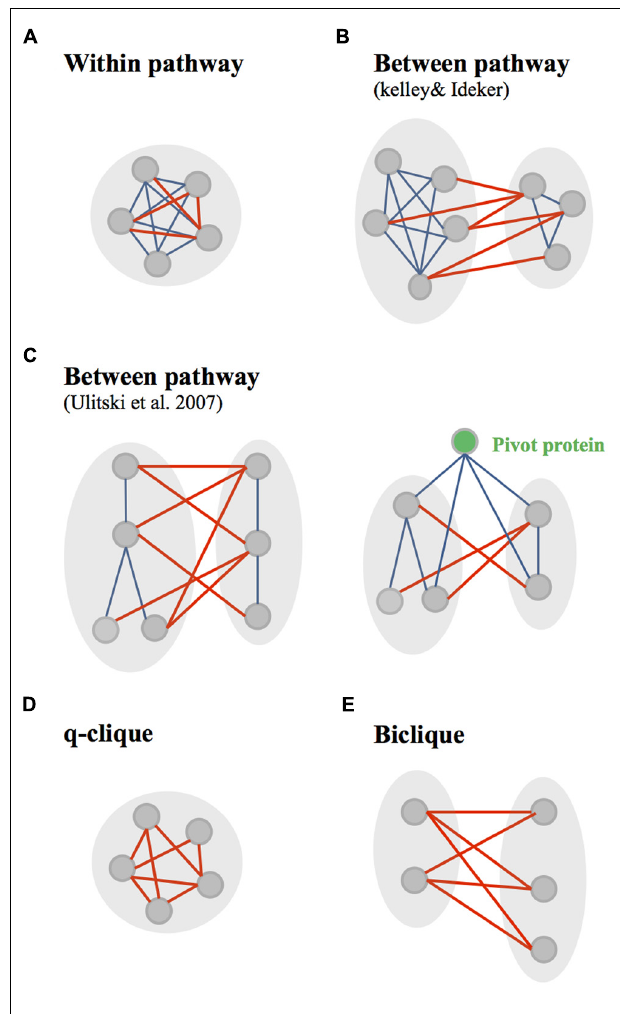
FIGURE 3 | Canonical and non-canonical within/between pathway models. (A) The canonical within pathway model as described by Kelley and Ideker, consists in genetic interactions (GIs, red edges) occurring within a dense module of protein interactions (bleu edges). (B) The canonical between pathway models, as described by Kelley and Ideker (2005) , consists in GIs occurring between dense modules of protein interactions. (C) The canonical between pathway models, as defined by Ulitsky etal., 2008, consist in GIs occurring between connected subnetworks/graph modules of protein interactions.This study also identified pivot proteins as proteins highly connected at the molecular level with component of two subnetworks connected through between pathway GIs. (D) Non-canonical within pathway model, are quasi-cliques (q-cliques), biclusters of highly connected genes. (E) The non-canonical between pathway models consist in bicliques – biclusters in which prays and target genes of GIs do not